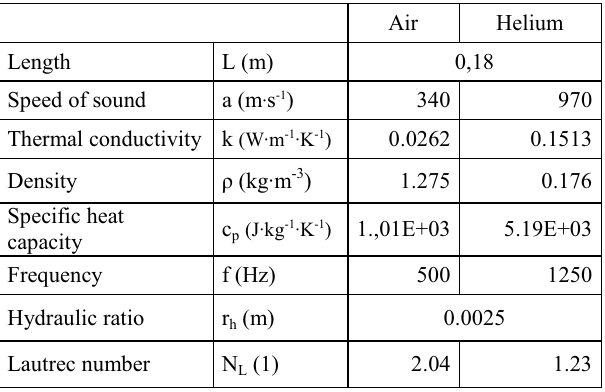
Table 2. Basic parameters of working gases and